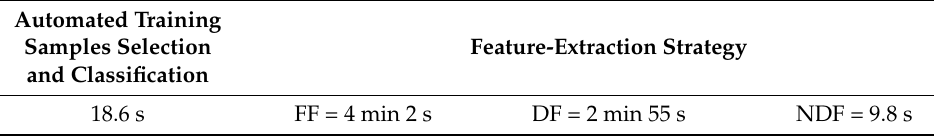
Table 8. Processing time of proposed self-supervised method for mapping building damage for each feature-extraction strategy.